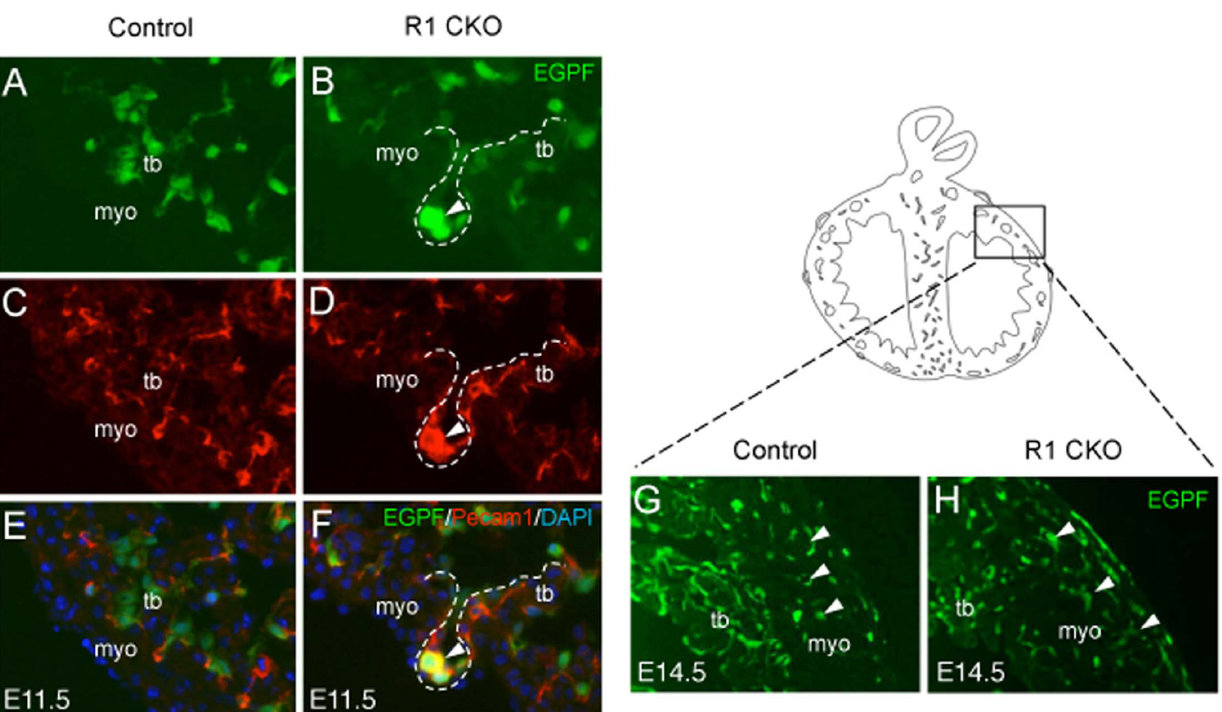
Figure 5. R1 CKO endocardial cells generate the precocious coronary plexuses. A, B, Image of cultured E11.5 ventricle showing EGFP labeled plexus ( B, arrowhead). C, D, Images showing Pecam1 stained plexus ( D, arrowhead). E, F, Merged images showing EGFP/Pecam1 co-staining plexus ( F, arrowhead). G, H, EGFP-labeling showing comparable coronary vasculatures between the E14.5 control ( G ) and R1 CKO heart ( H ). myo, myocardium; tb,